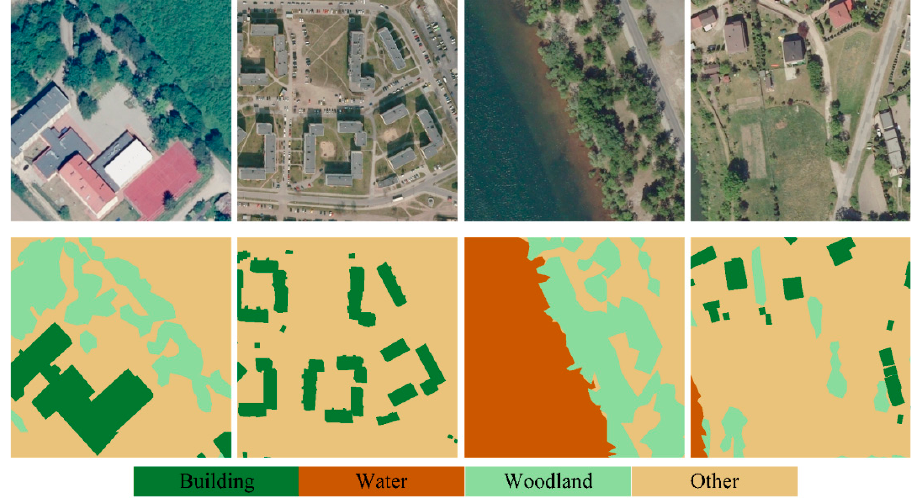
Figure 6. Some typical sample images of landcover.ai and their corresponding labels.